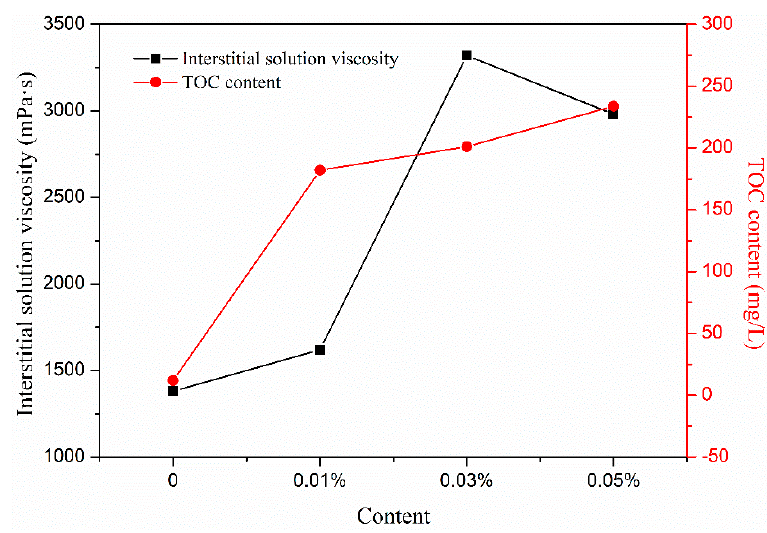
Figure 7. Total organic carbon (TOC) content and NDJ viscosity of cement mortar interstitial solution.